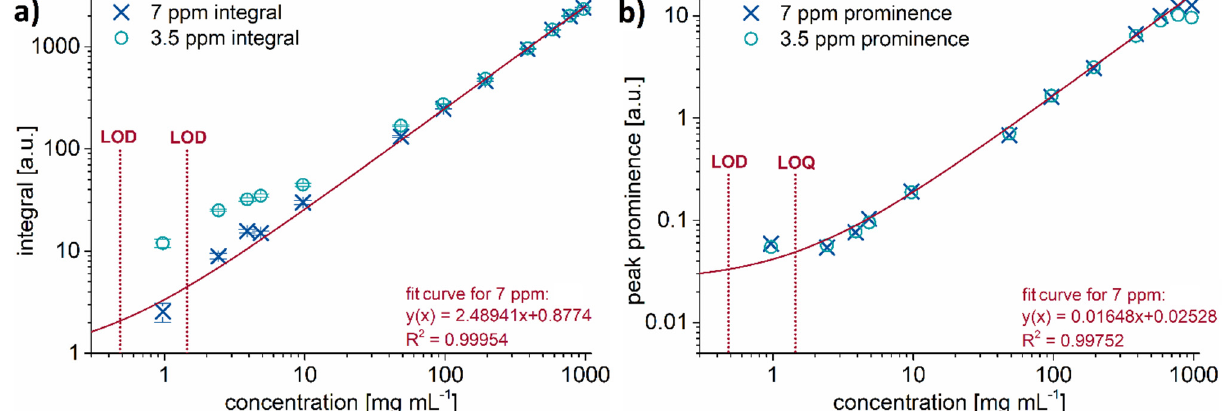
Figure 3. ( a ) Integral and ( b ) peak prominence of the ester (3.5 ppm) and aromatic (7 ppm) peak regions of DINP solutions using non-deuterated n-hexane as a solvent. Concentrations range from 0.97 to 970 mg mL − 1 . The continuous lines are the fit results for the signal at 7 ppm showing the excellent linear correlation between the NMR integral ( a ) or the peak prominence ( b ) and the plasticizer concentration as demonstrated by the R 2 value. The apparent curvature of the linear fit is due to the log–log scaling of the axes.